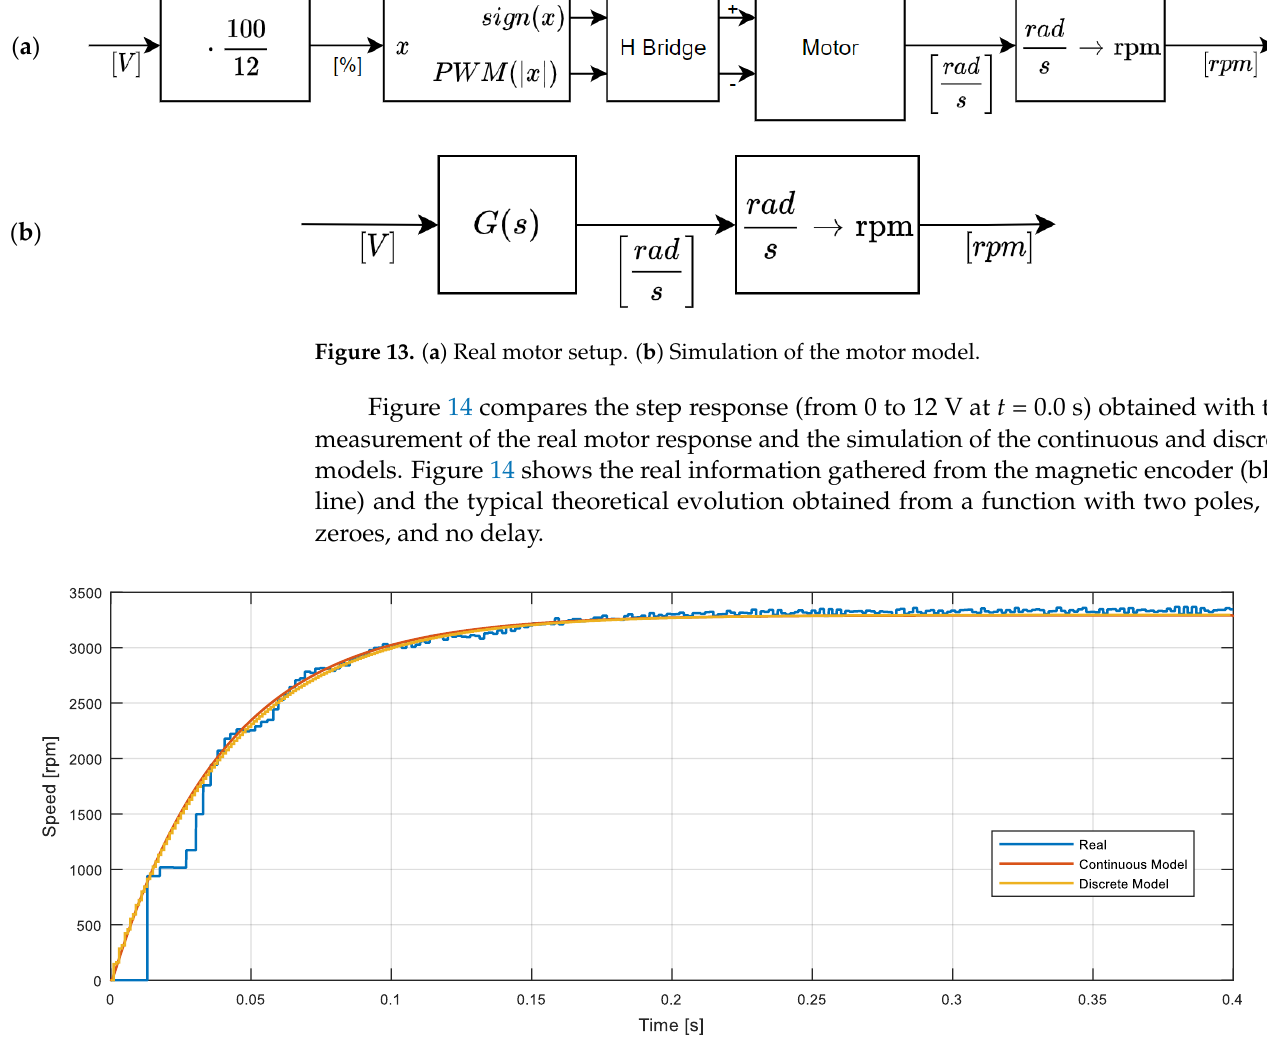
Figure 14. Open-loop motor step response comparison: real motor speed gathered from the encoder (blue line), continuous-time (red line) model simulation, and discrete-time (brown line) model simulation.